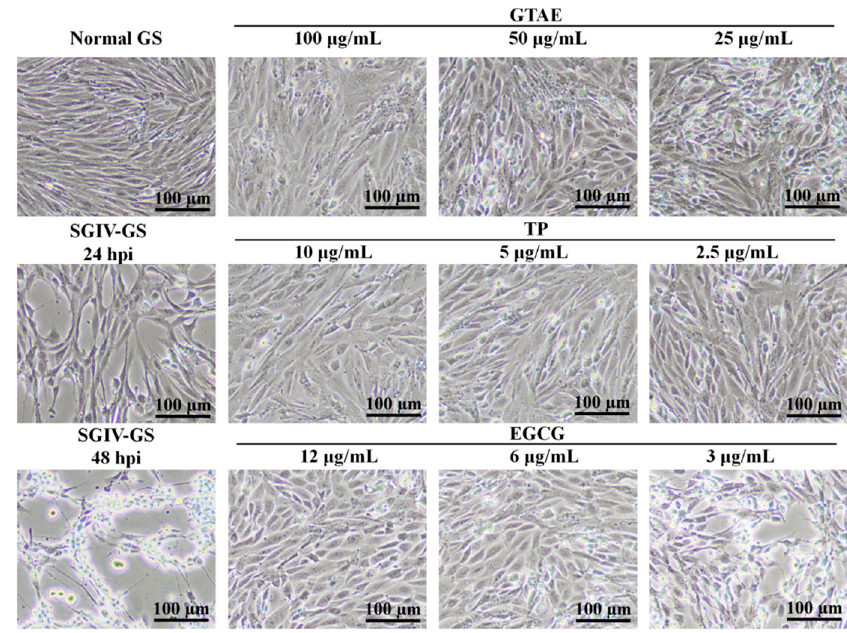
Figure 4. The antiviral activities of green tea components against SGIV observed with light microscopy at 48 h. GS cells incubated with SGIV and diluted green tea components (GTAE at 100, 50, or 25 μ g/mL; TP at 10, 5, or 2.5 μ g/mL; and EGCG at 12, 6, or 3 μ g/mL) constituted the test groups. GS cells infected with SGIV-only constituted the positive control group. GS cells incubated with L15 medium only constituted the negative control group. Each green tea component had the greatest antiviral effect at its safe working concentration (GTAE at 100 μ g/mL, TP at 10 μ g/mL, and EGCG at 12 μ g/mL).